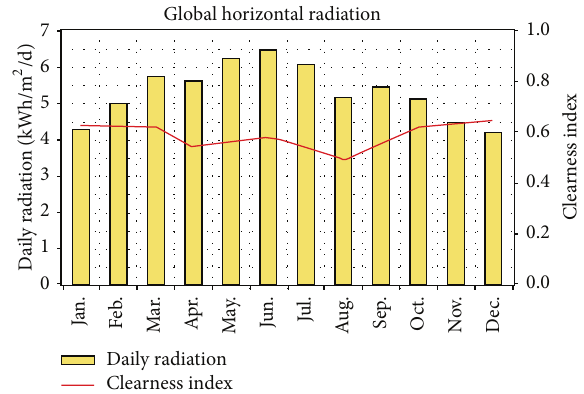
Figure 3: Profile of solar radiation in Sohar,